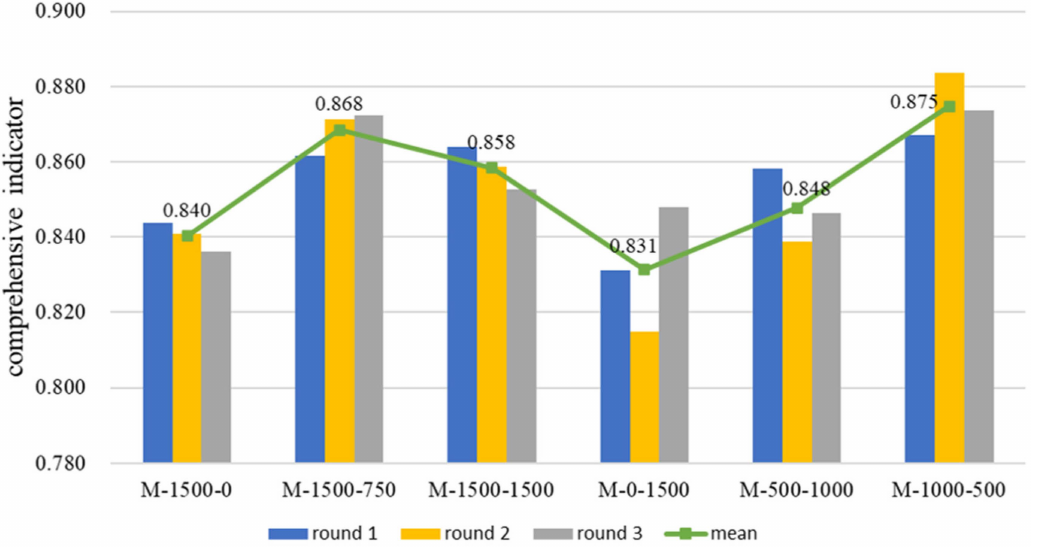
Figure 18. The results of three repeated experiments (comprehensive